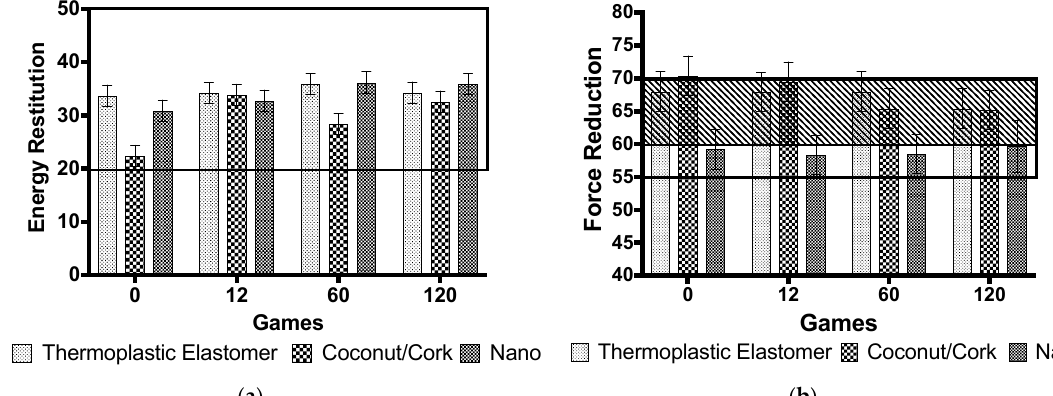
Figure 3. ( a ) Mean energy restitution values for three alternative infills at 0, 12, 65, and 120 games. Blue area represents FIFA 2 star ratings ( b ) Mean force reduction values for three alternative infills at 0, 12, 65, and 120 games. The colored area represents FIFA 1 star requirements while the diagonal area represents FIFA 2 start requirements. Both energy restitution and force reduction were collected using the triple a tester. Error bars represent standard error of the